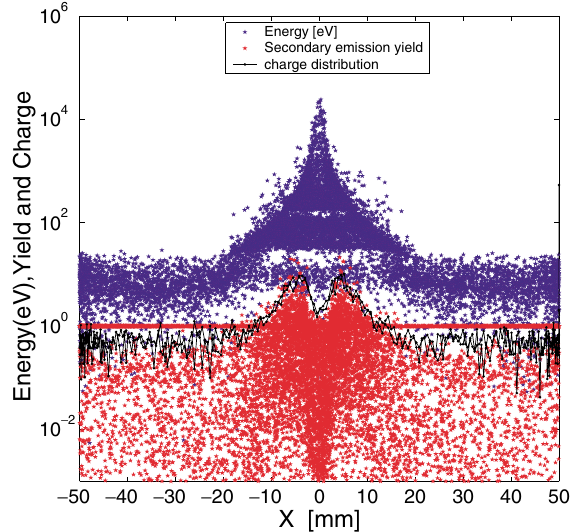
FIG. 9. (Color) Mechanism of multipacting in the dipole mag- net. Blue dots show the energy of photoelectrons which hit the chamber wall. Red dots represent the secondary emission yield of the photoelectrons which hit the wall. The black solid line is the charge distribution of the lost photoelectrons, which is normalized by the number 10 12 in order to compare the charge distribution with the secondary emission yield